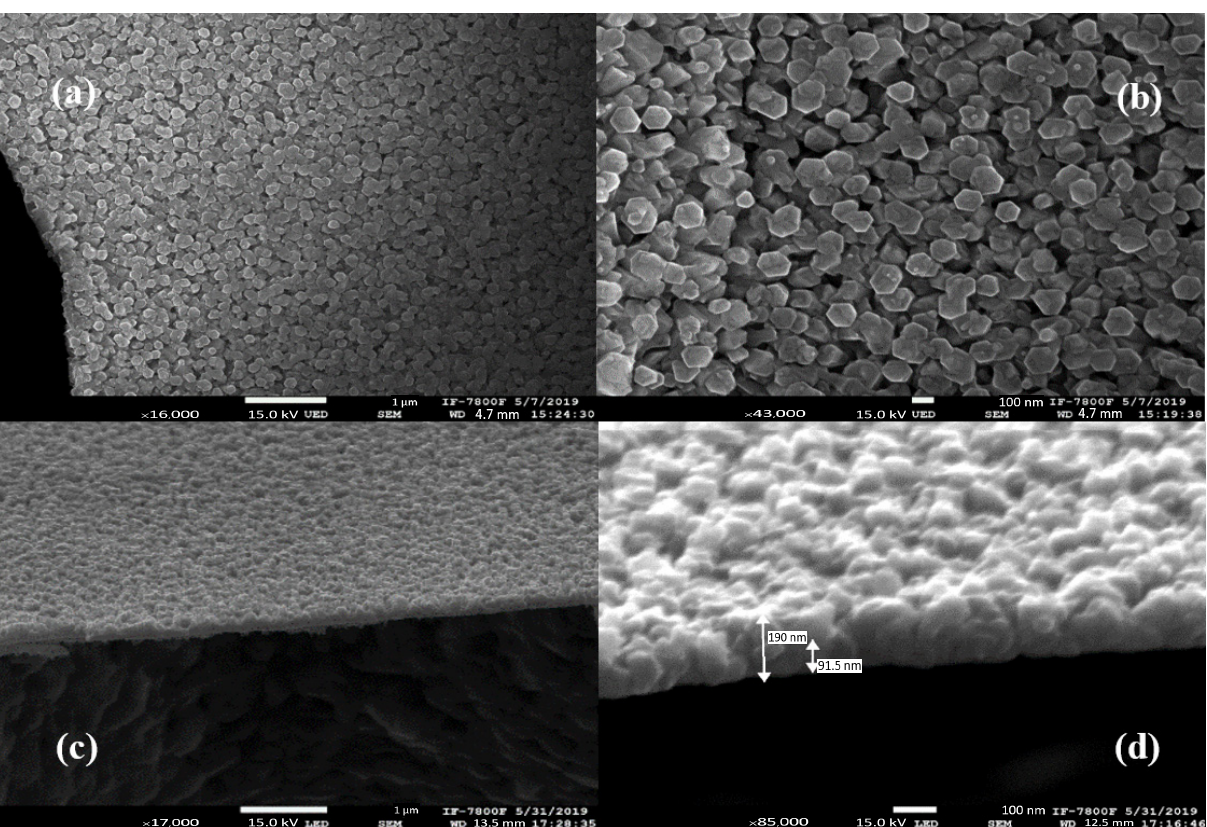
Figure 8. Micrograph of the deposition made on NaCl substrate ( a ) surface at magnification 16,000×, ( b ) surface at magnification 43,000×, ( c ) cross-section at magnification 17,000×, (d) cross-section at magnification 85,000×.